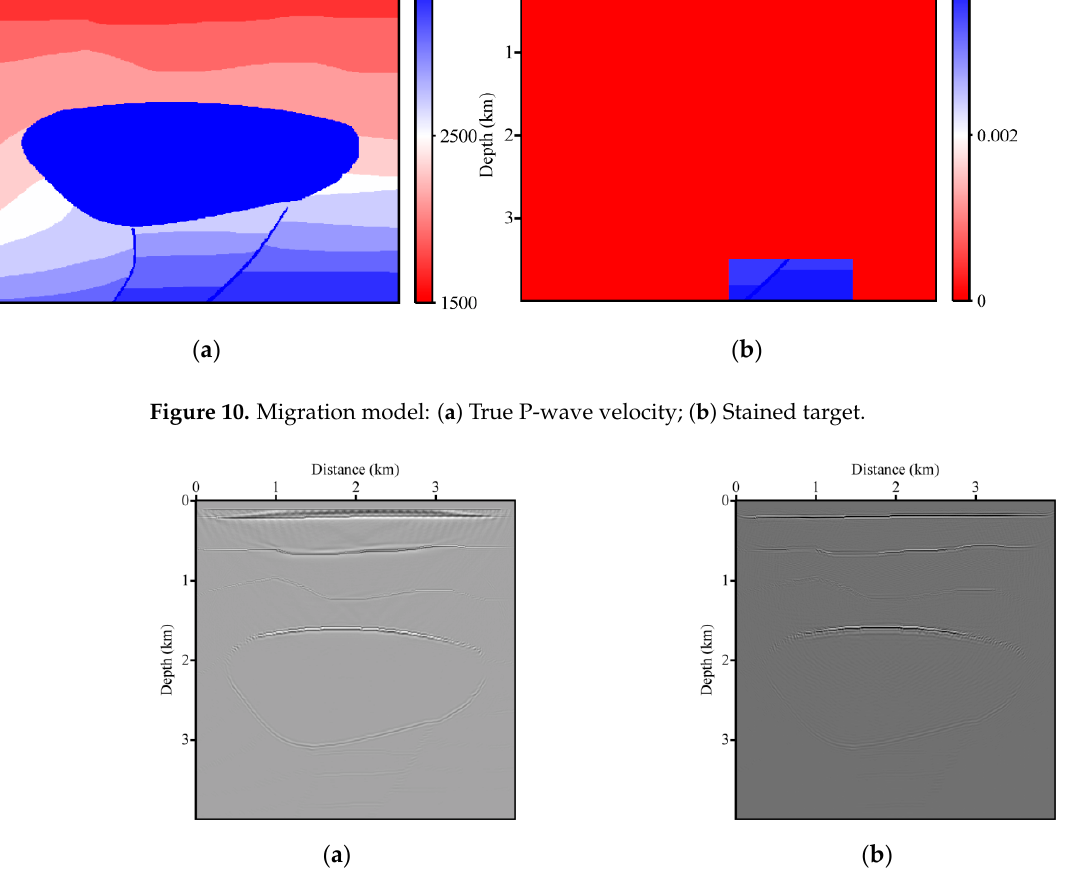
Figure 11. ERTM images based on the VDWE: ( a ) PP imaging; ( b ) PS imaging.